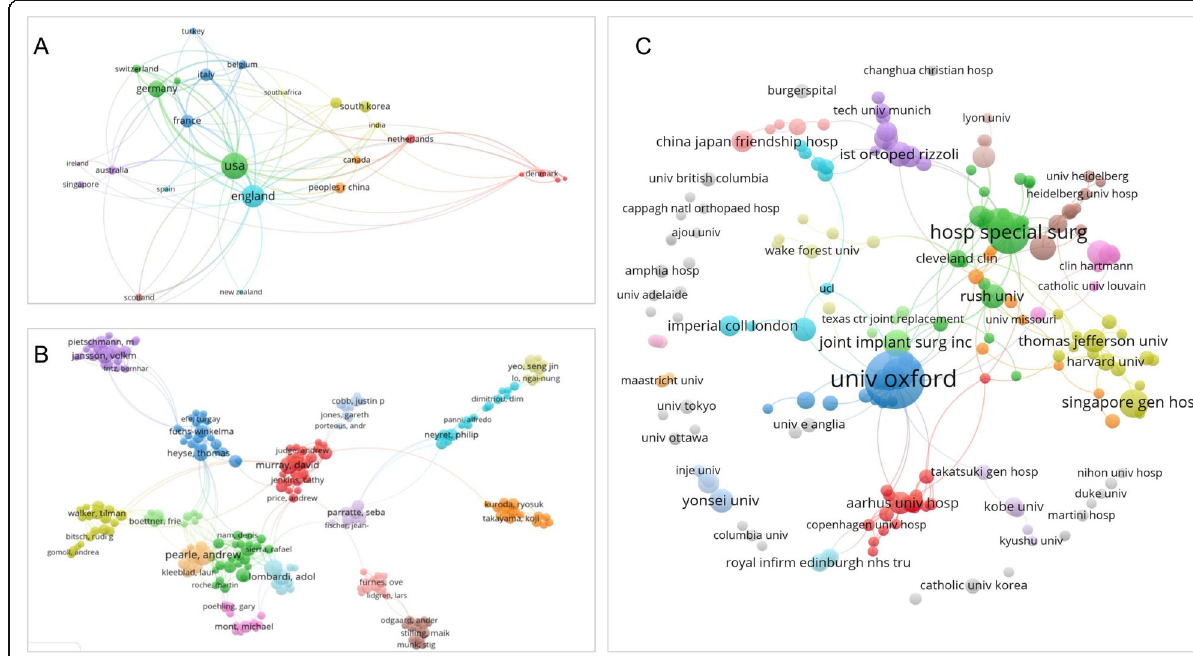
Fig. 4 Document coupling analysis. The size of the circle reflects the weight of the literature, and the color of the circle represents the clustering. The more or thicker the lines between the circles, the higher the intensity connection ( a : country coupling analysis; b author coupling analysis; c : organization coupling